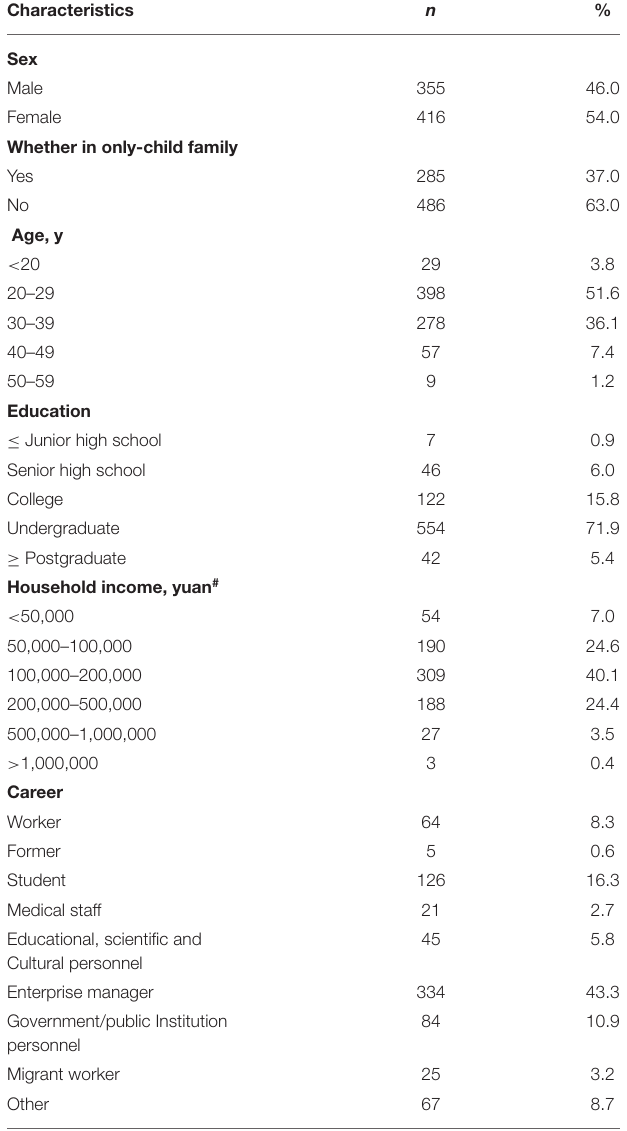
TABLE 1 | Participant demographic information ( N =